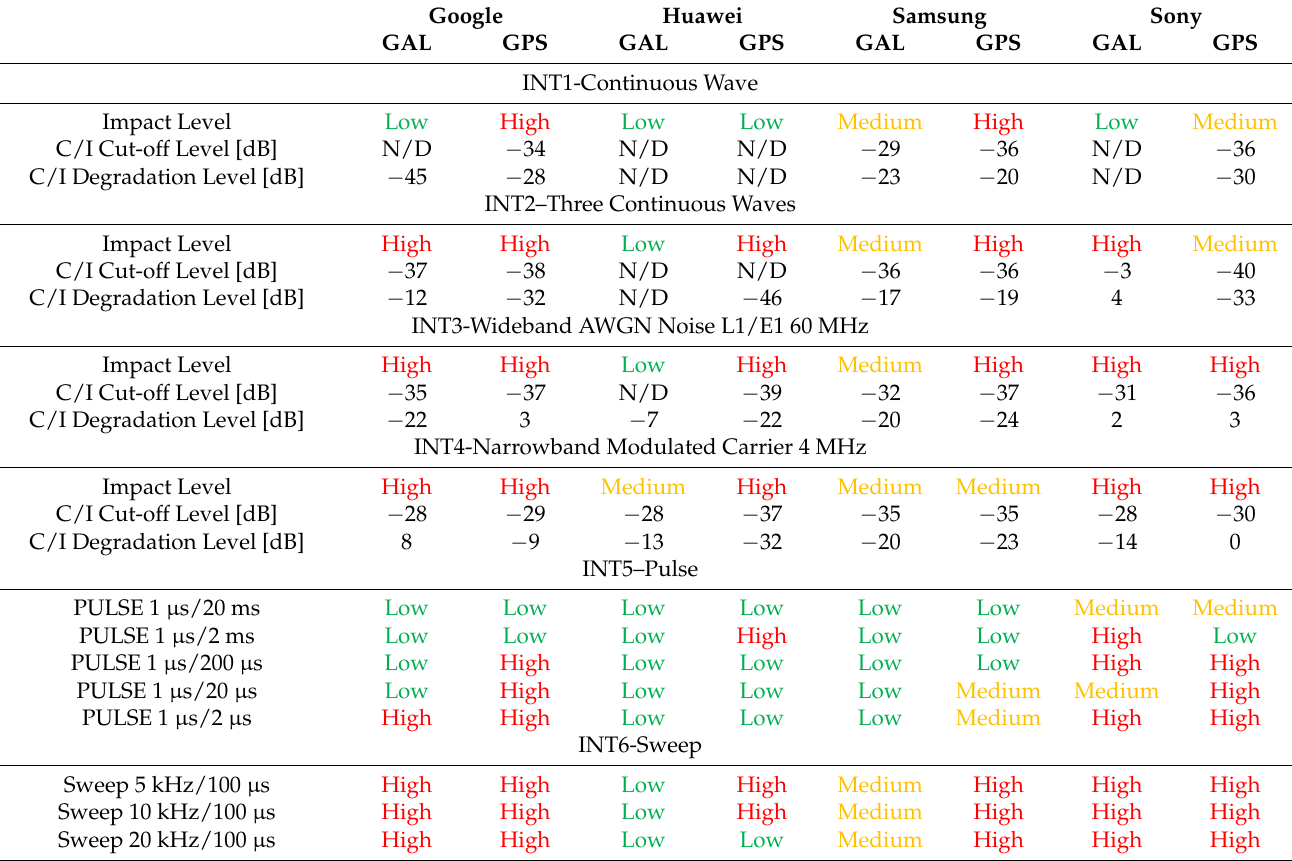
Table 2. Impact level of various interferences for static jamming tests. Google Huawei Samsung Sony GAL GPS GAL GPS GAL GPS GAL GPS INT1-Continuous Wave